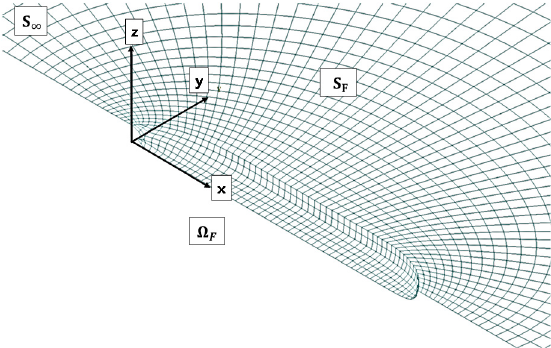
Figure 1. Linear pressure